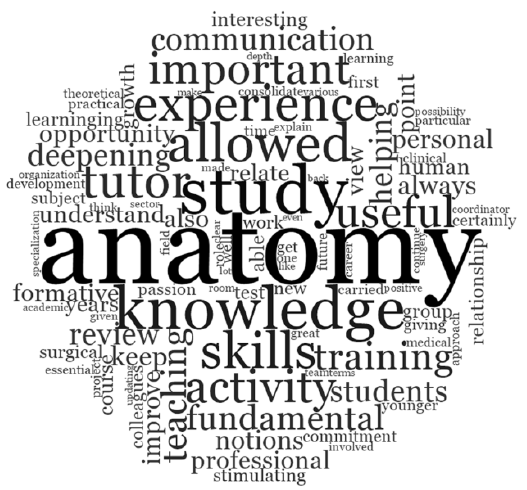
Figure 5. Word cloud representing tutors’ responses to the open-ended question: “Describe the role near-peer tutoring experience plays/played in your professional career”.